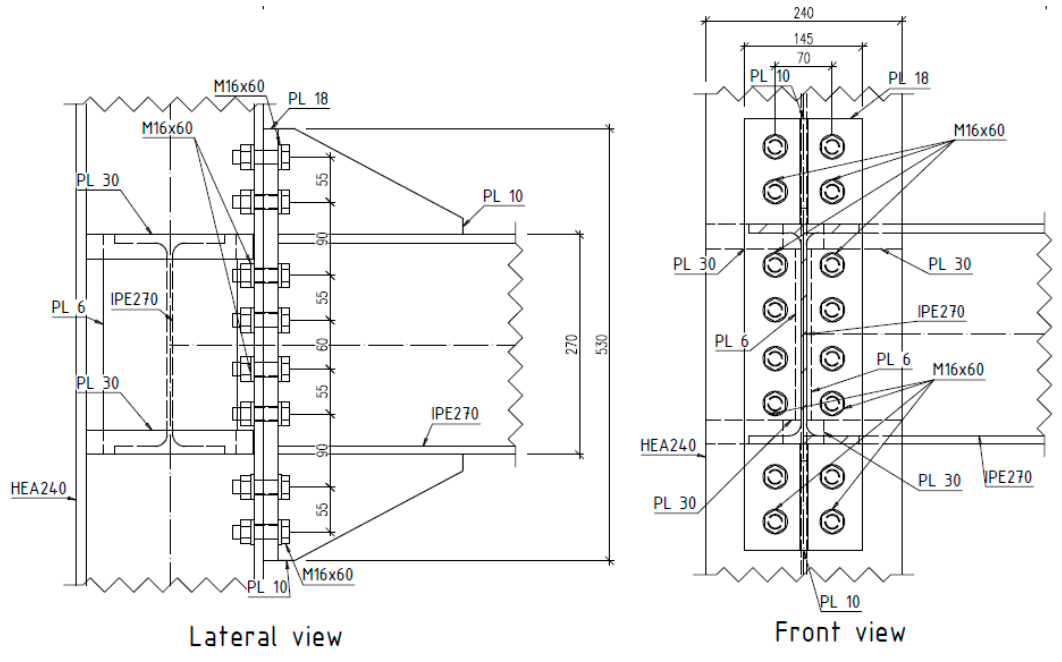
Figure 4. Lateral and front view of the pre-qualified connection designed. Dimensions in millimeters.